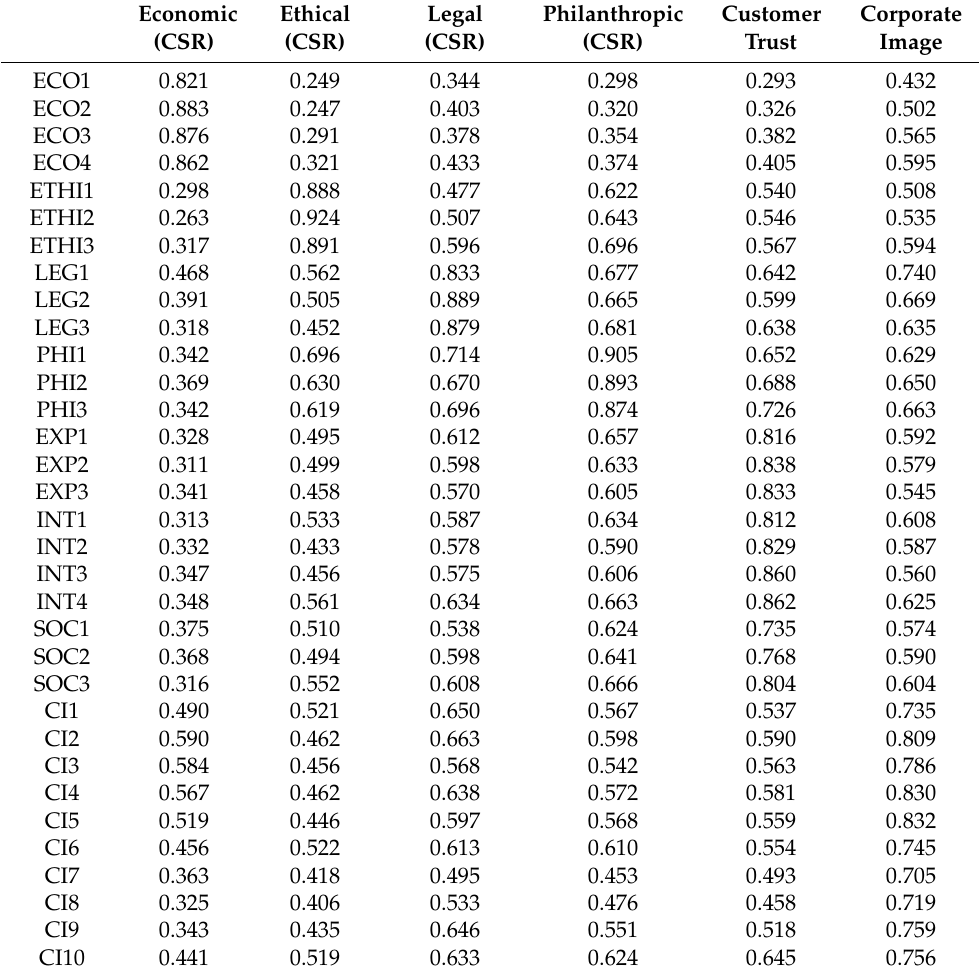
Table 2. Standardized factor loadings and cross-loadings of the outer